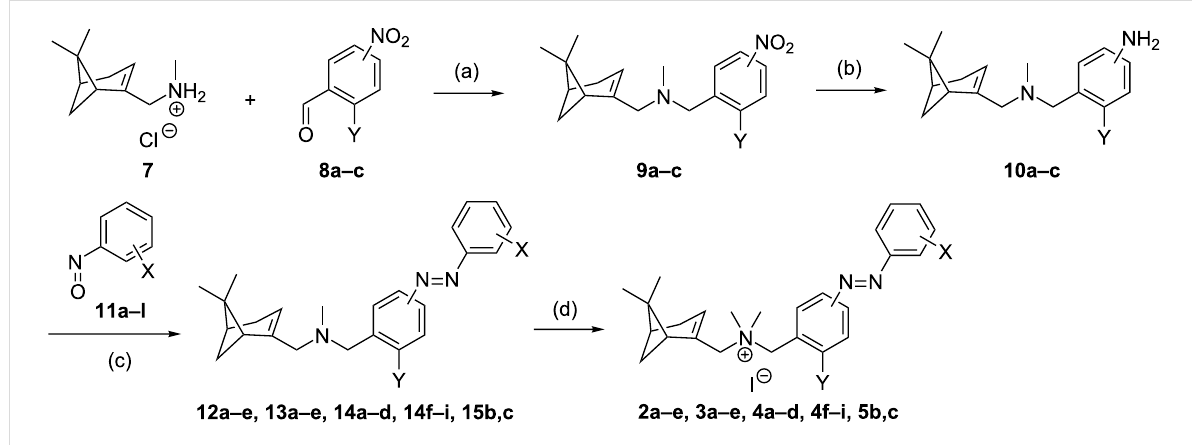
of a radiolabeled small-molecule CXCR3 antagonist ([ 3 H]-VUF11211 [31]). Values reported are mean ± SEM